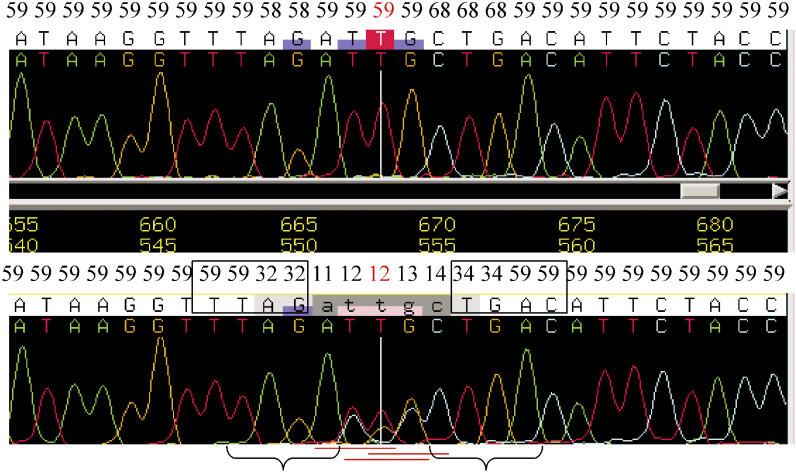
Sequence Traces of a SNP Cluster with Three Consecutive SNPsThe top is a homozygous sample and the bottom a heterozygous one. The Phred quality score is labeled on top of each base. In the heterozygous sample, the three HQDPs around the three heterozygotes are labeled with red lines at the bottom. The flanking bases used for calculating genotype quality class of the highlighted heterozygote in the middle are marked by rectangular boxes, which do not include any HQDPs. The flanking bases used to assess background noise in the flanking region are labeled with brackets at the bottom.